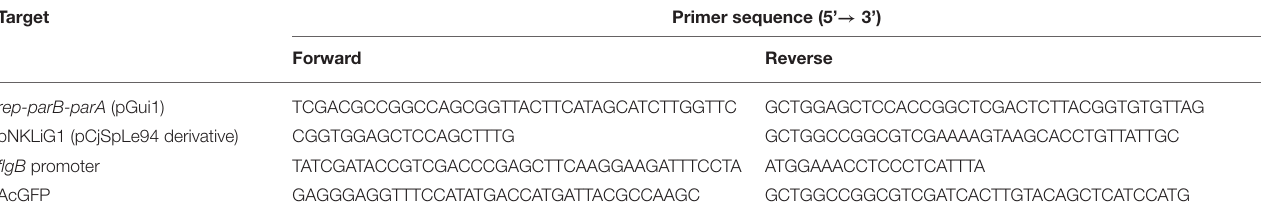
Supplementary Table S1 | Primer sequences used in this